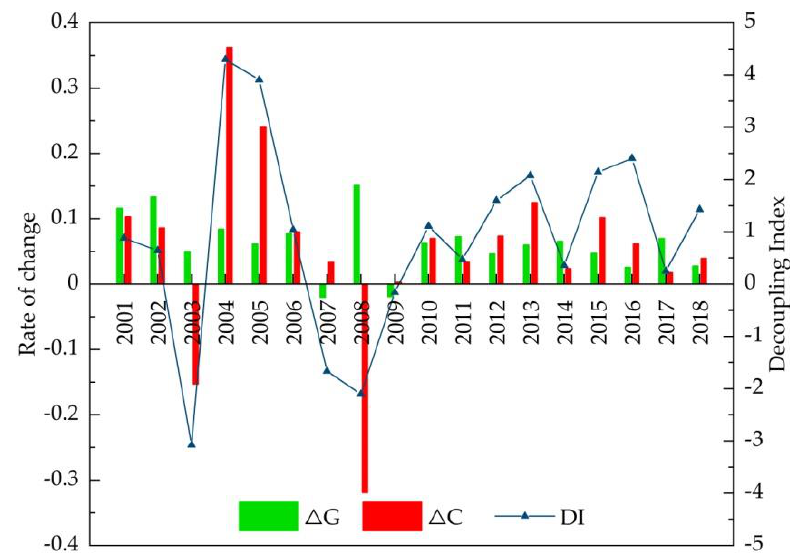
Figure 3. The change in the decoupling index of agricultural carbon emissions.